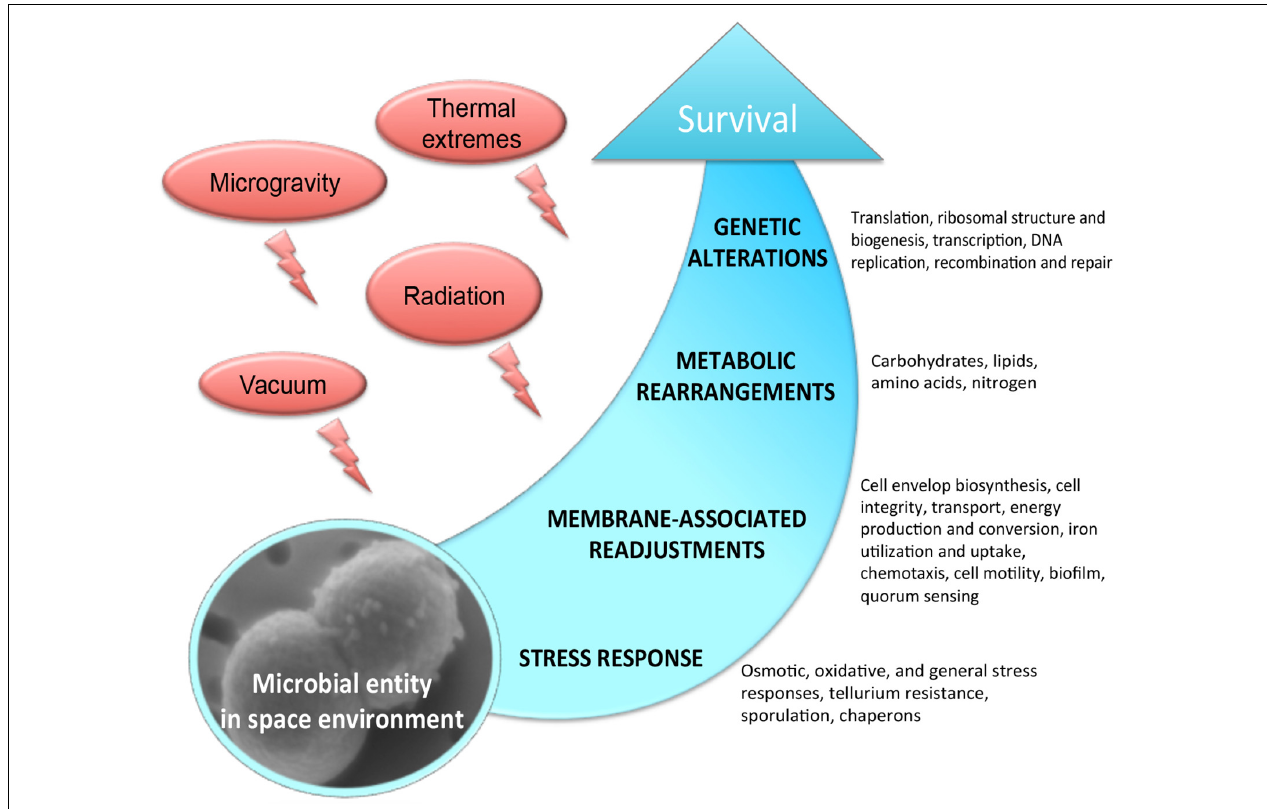
FIGURE 1 | Molecular response experienced by microorganisms in the outer space environment.